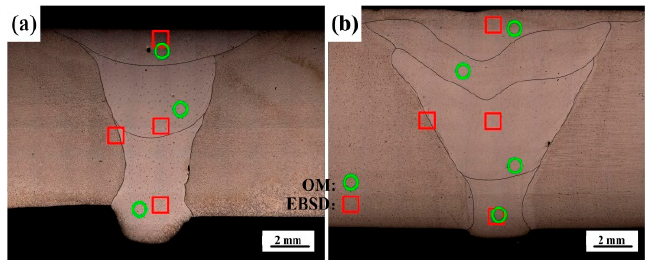
Figure 3. Transverse section of the welded joints for the ( a ) 1670-8 and ( b ) 1670-14.